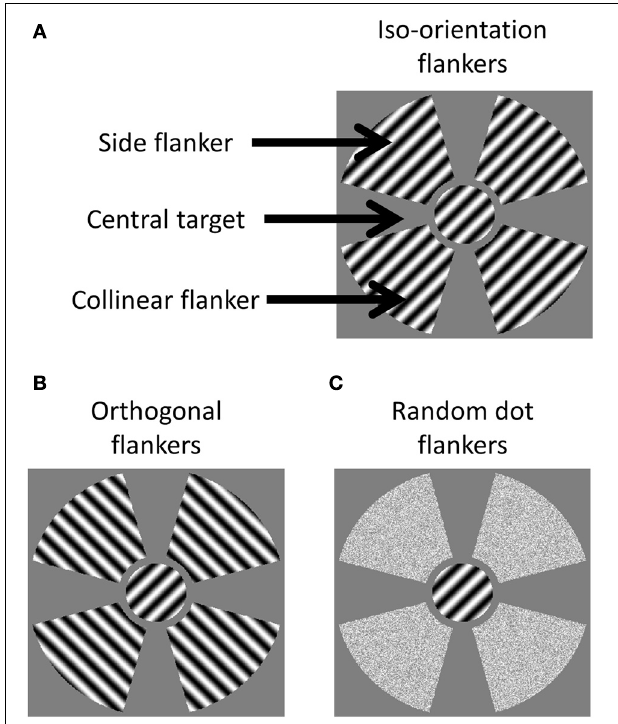
FIGURE 1 | cIllustration of stimuli in the three test conditions. (A) The Iso-orientation condition with three image components labeled; (B) the orthogonal condition; and (C) the random dot